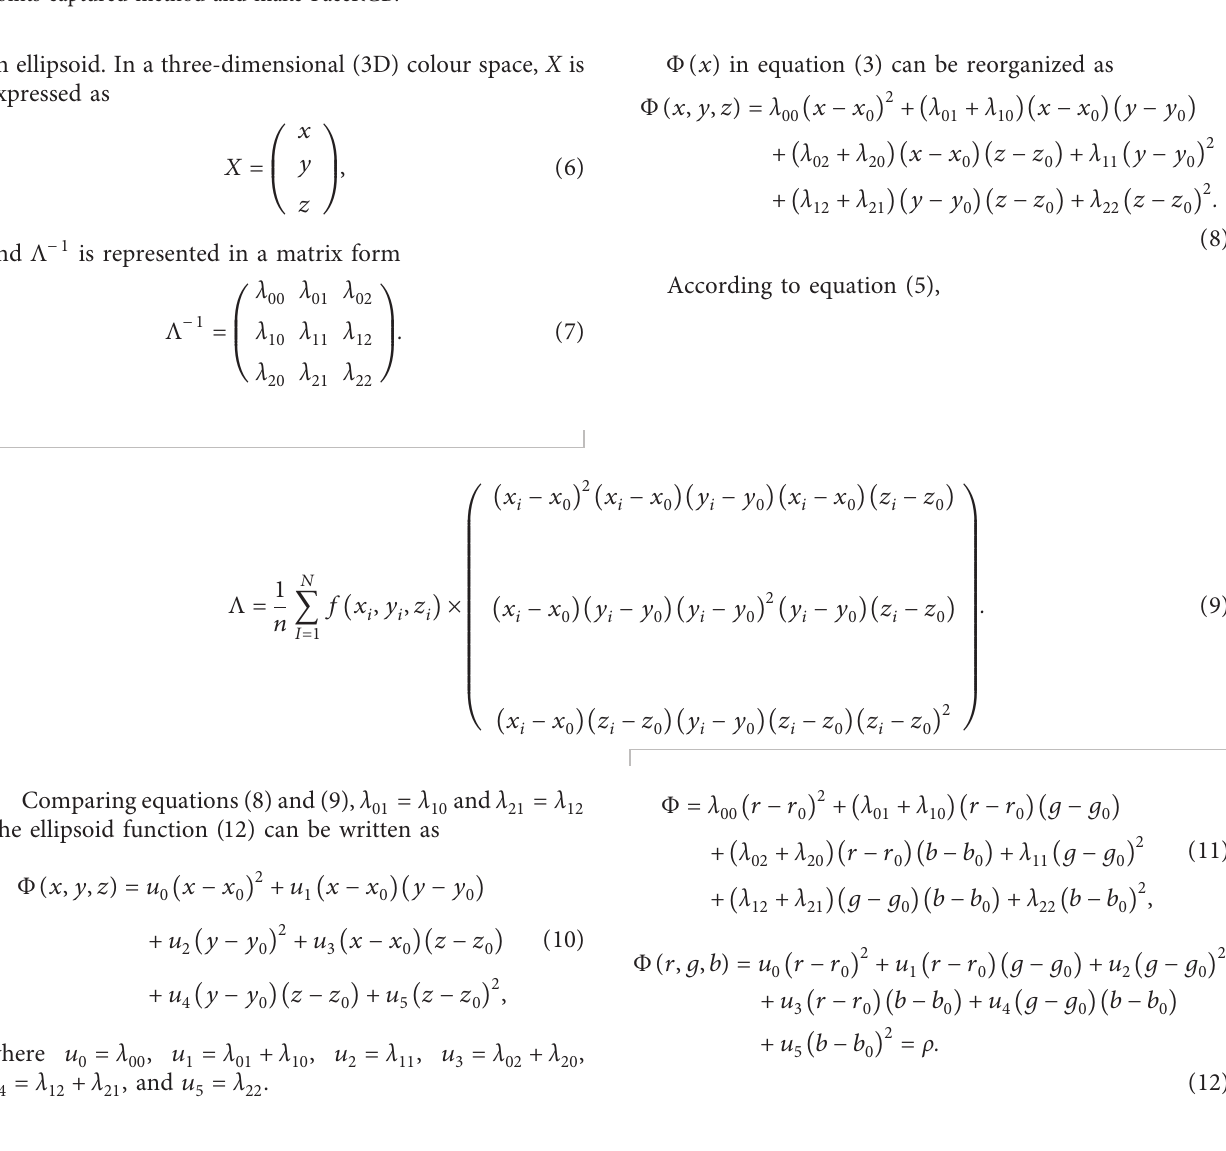
Figure 1: From Ellipsolid theory, make the SCE program to detect facial colour by each photo; Through the Taguchi method, get the 6- points captured method and make